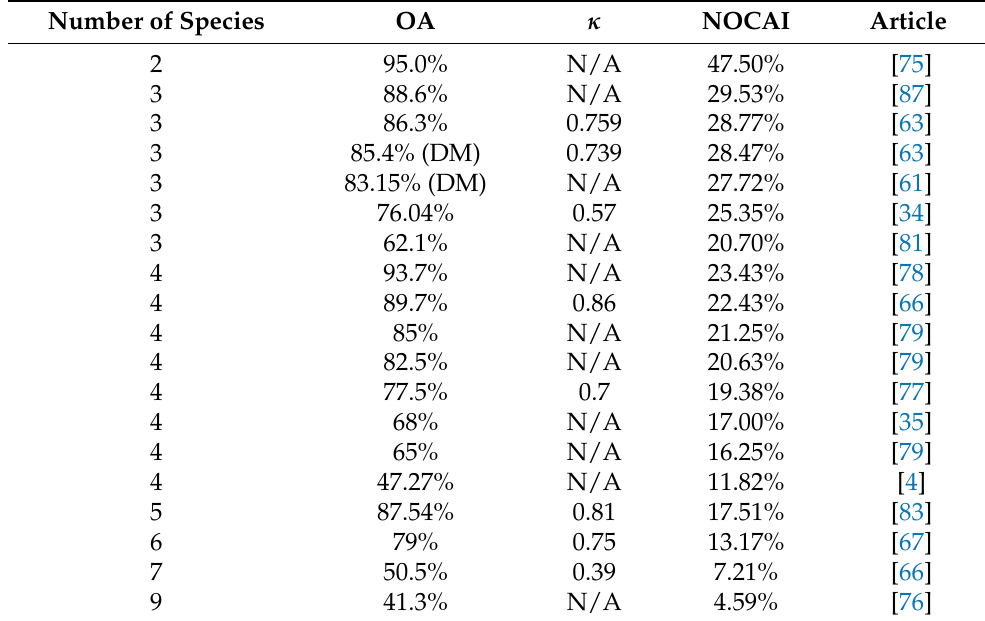
Table A1. List of results of reviewed studies where species classification was performed with a geometry feature group; list sorted by species number and overall accuracy; DM—additional information for studies where trees were delineated